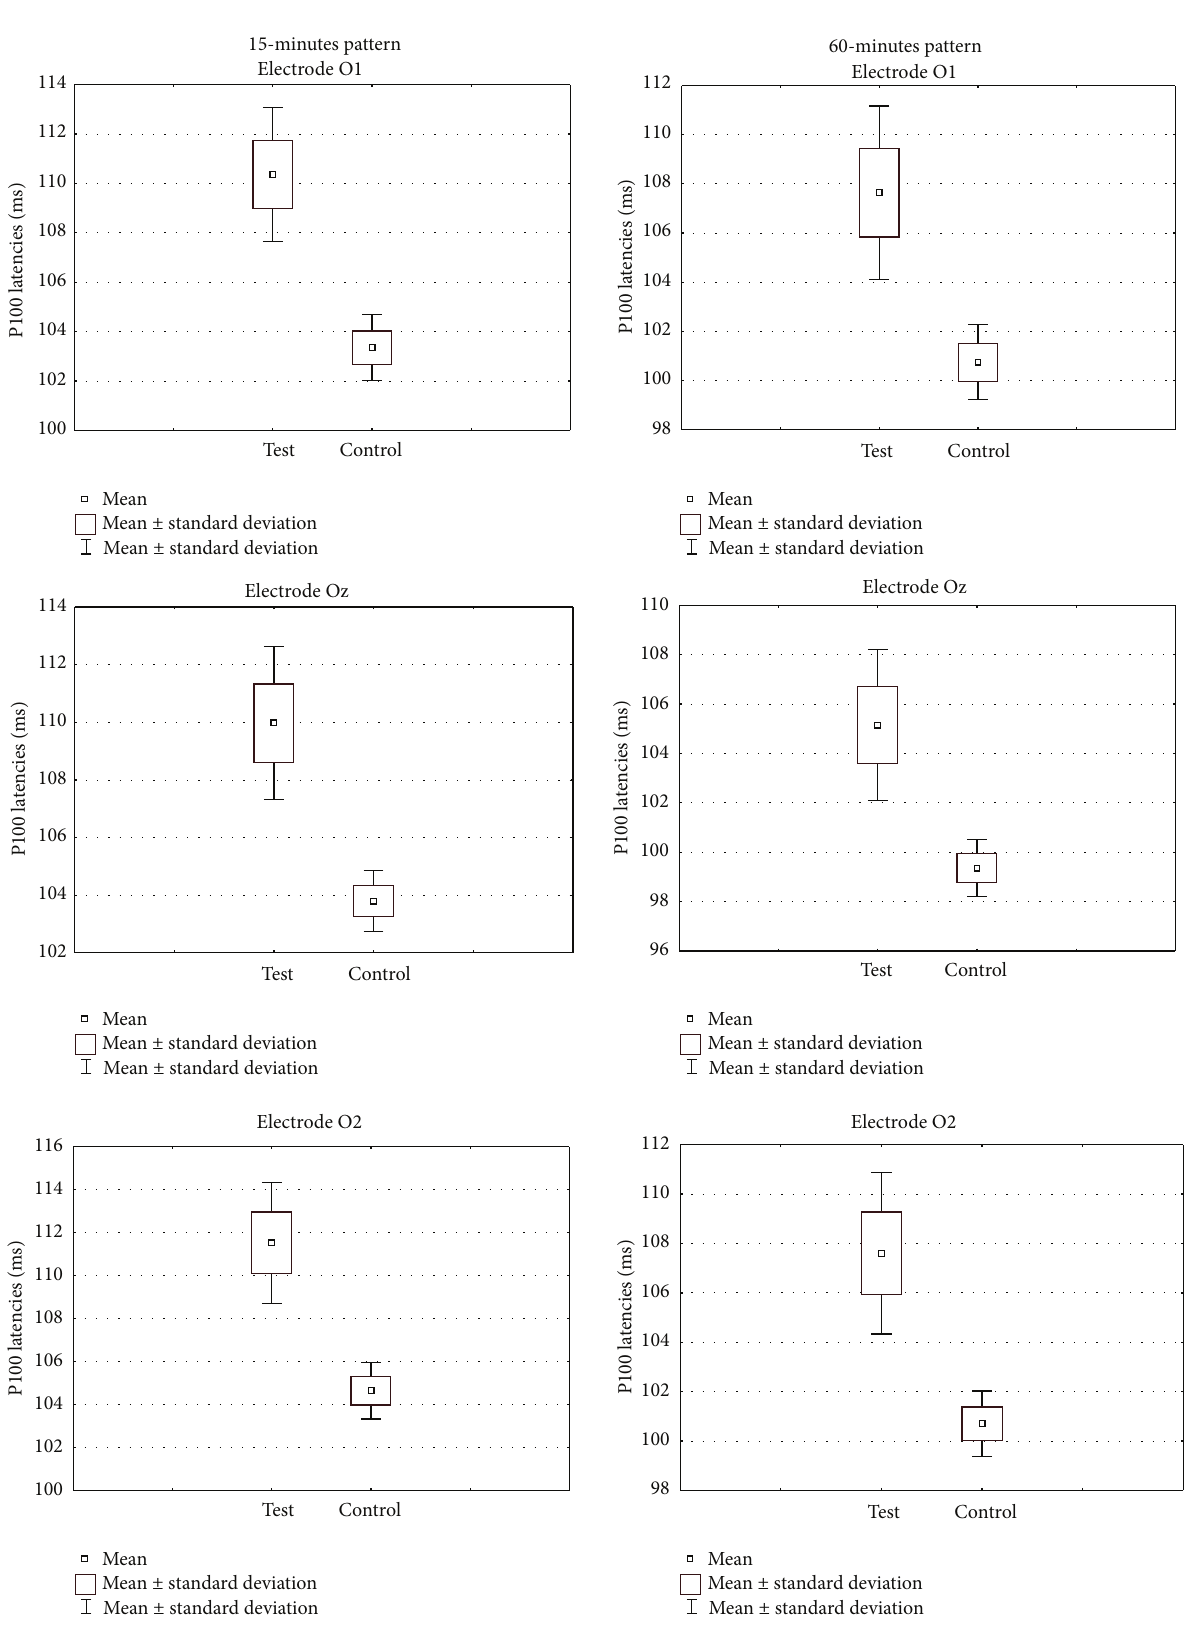
Figure 3: Whiskers diagrams highlight P100 wave amplitudes ( 𝜇 m) and P100 wave latencies (ms) significant differences between the test and the control